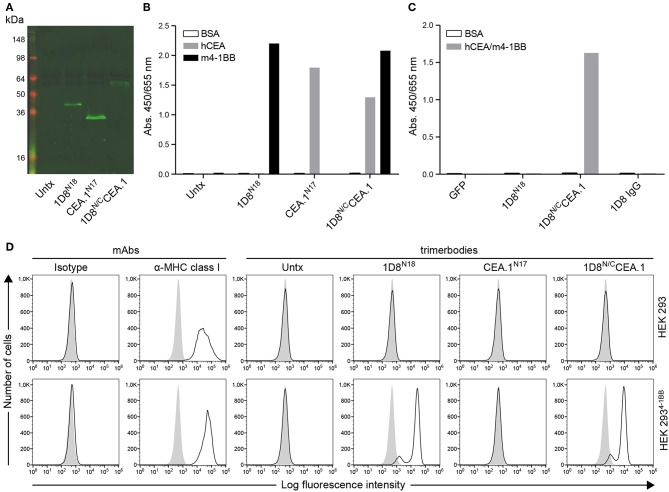
Characterization of secreted 1D8N/CCEA.1trimerbody. (A) The presence of secreted trimerbodies in the conditioned media from untransfected (Untx) or transfected HEK293 cells was demonstrated by western blot analysis. Migration distances of molecular mass markers are indicated (kDa). The blots were developed with anti-c-myc mAb, followed by incubation with an IRDye800-conjugated goat anti-mouse IgG. The functionality of secreted trimerbodies was demonstrated by ELISA against plastic immobilized hCEA and m4-1BB (B). Simultaneous binding to hCEA and m4-1BB was assessed by dual ELISA by direct immobilization of hCEA, followed by 100 μl of neat supernatant from transfected HEK293 cells and addition of m4-1BB (C). Flow cytometry on HEK293 cells and HEK293m4−1BB cells (D), using 100 μl of neat supernatant from transiently transfected HEK293 cells. An anti-MHC class I mAb was used as control.